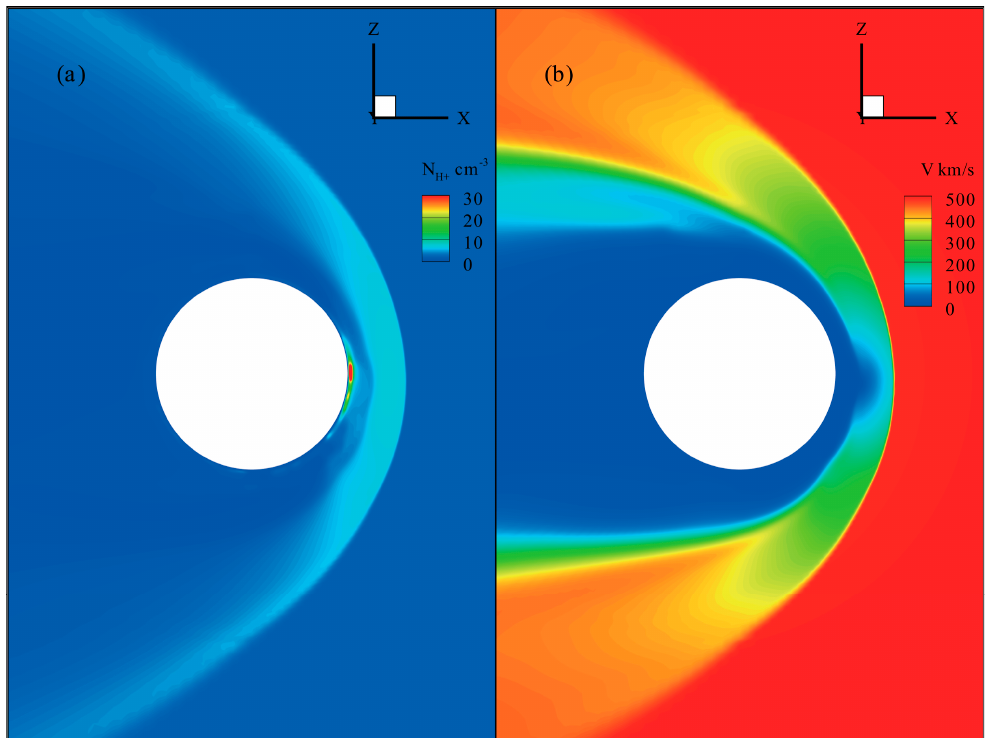
Figure 1. ( a ) Proton density and ( b ) velocity distributions simulated by the MHD model on the X–Z plane in the Mars Solar Orbital (MSO) frame. Table 2. Parameters of the exosphere model at the critical altitude 1